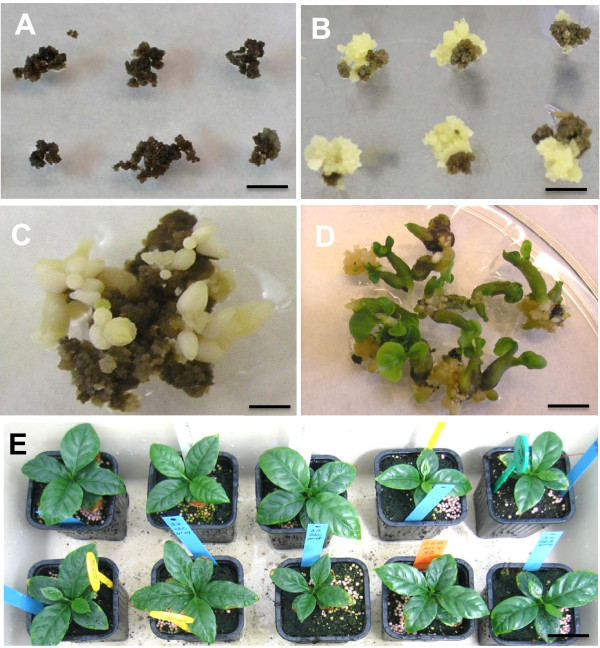
Regeneration of transformed coffee plants from maintained embryogenic cultures. Calli in selective media containing 100 mg.L-1hygromycin and 125 mg.L-1 cefotaxime 4 months after co-cultivation with A. tumefaciens LBA1119 without plasmid, used as control (A). Regeneration of resistant calli in selective media containing 100 mg.L-1hygromycin and 125 mg.L-1 cefotaxime 4 months after co-cultivation with A. tumefaciens LBA1119 carrying pMDC32; the yellow calli are resistant to hygromycin (B). Regeneration of torpedo-shaped somatic embryos 6 months after co-cultivation (C). In vitro plantlet development 8 months after co-cultivation (D). Transgenic plants in the greenhouse 12 months after co-cultivation (E).